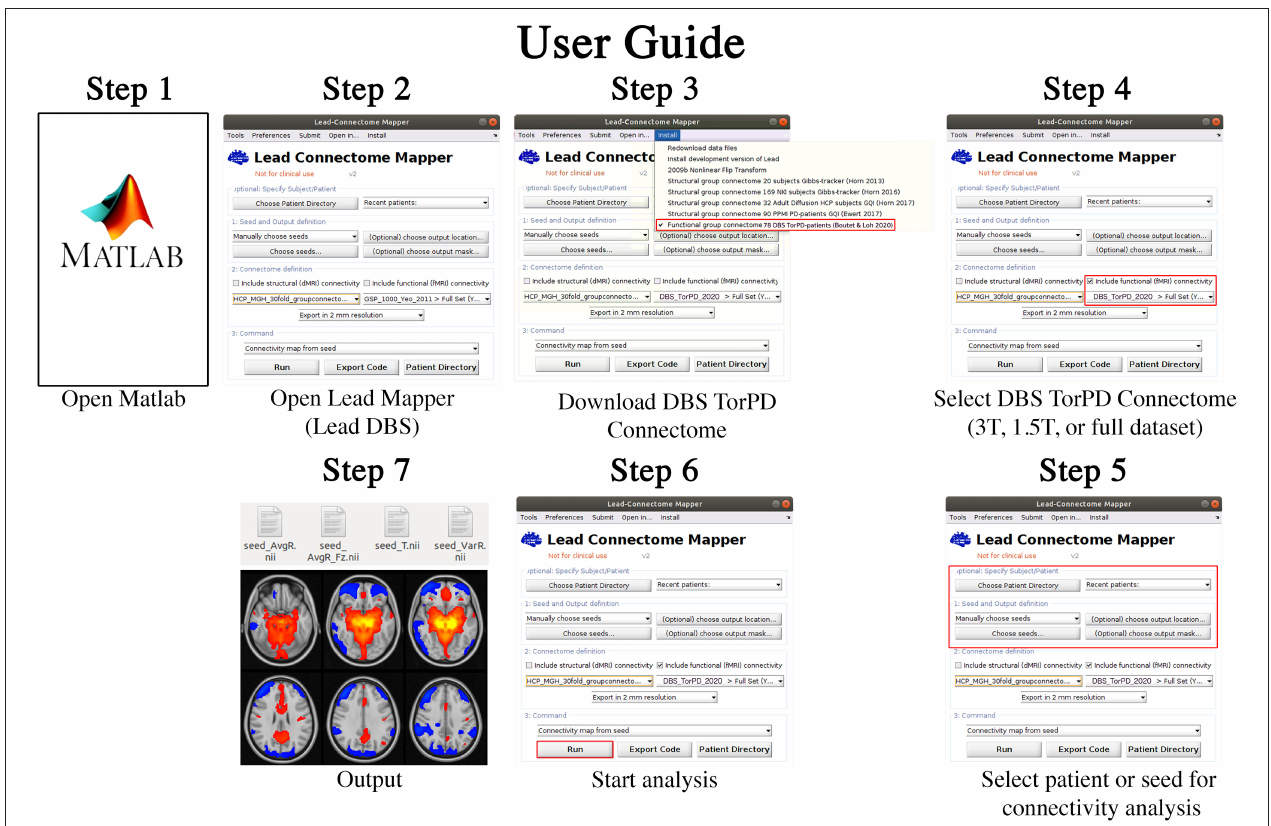
FIGURE 1 | Tor-PD User Guide. A visual guide detailing how to use the Tor-PD connectome to perform normative functional connectivity analyses. Step 1: Open Matlab. Step 2: In Matlab, open Lead Mapper. Step 3: Install the Tor-PD connectome. Step 4: Check the box ‘include functional (fMRI) connectivity’ and select ‘DBS_TorPD_2020’ from the dropdown menu. Step 5: Select the patient or seed for connectivity analysis. Step 6: Run the analysis. Step 7: The analysis will output four NIfTI files showing connectivity of the seed to the rest of the brain. DBS, deep brain stimulation; fMRI, functional magnetic resonance imaging; NIfTI,